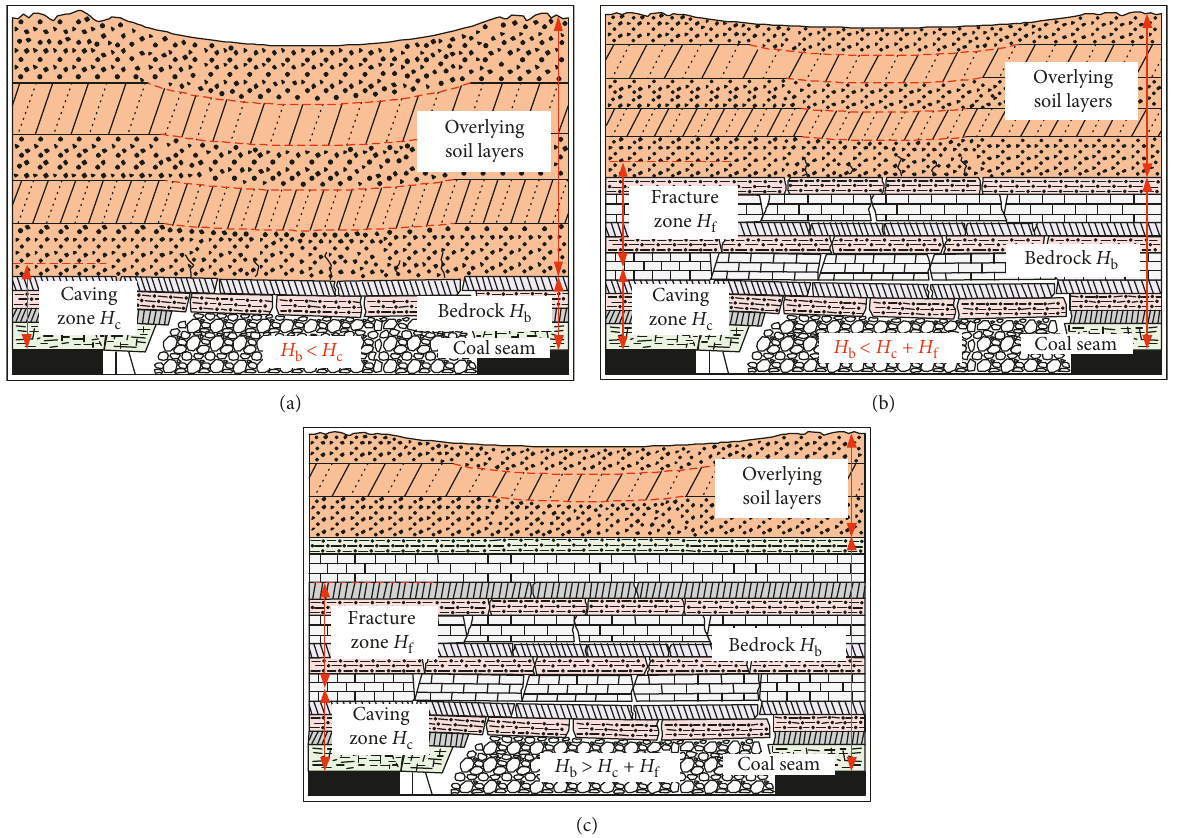
Figure 1: Classification diagram of bedrock: (a) ultrathin bedrock, H H b > H c + H f .